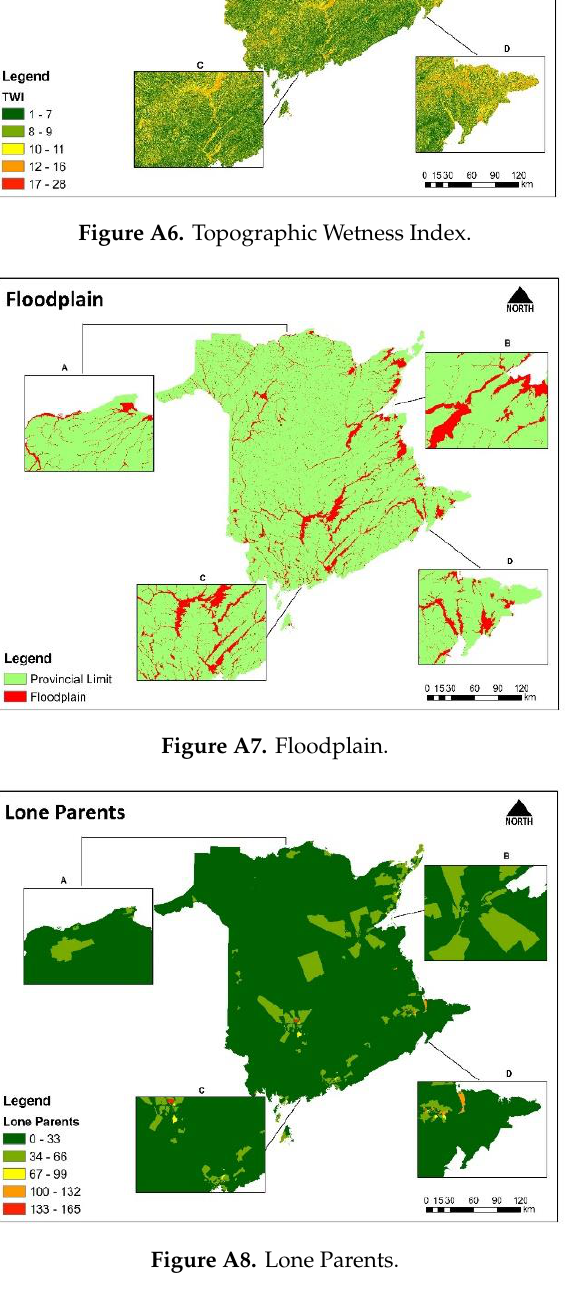
Figure A8. Lone Figure A8. Lone Parents.